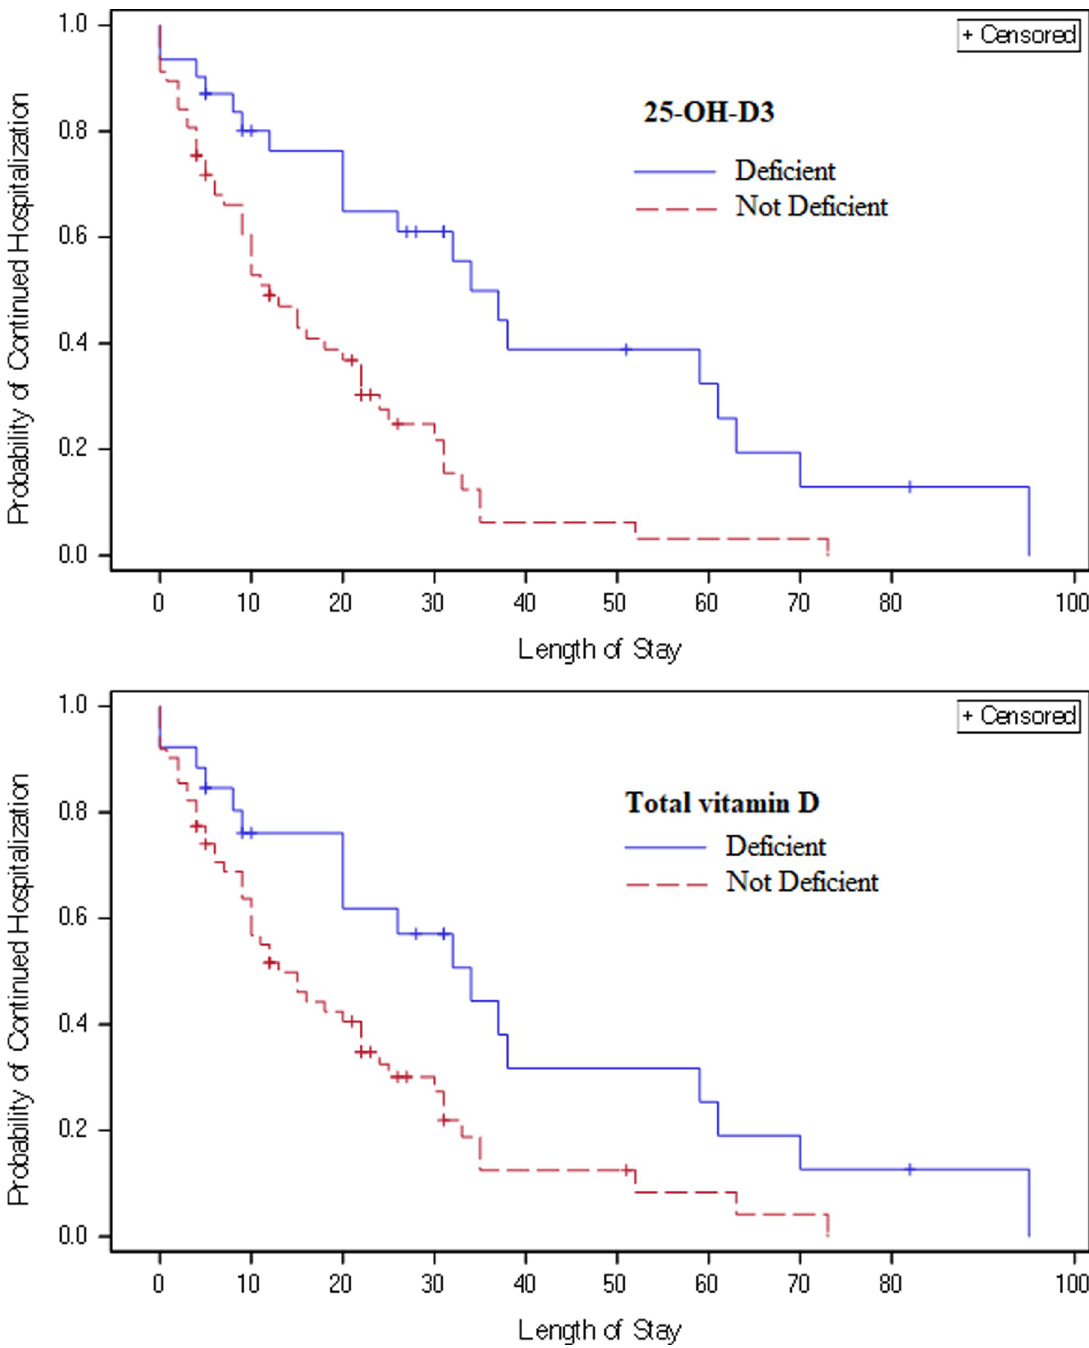
Fig 2. Kaplan-Meier curves for hospital discharge. Unadjusted Kaplan-Meier curves for hospital discharge by 25-OH-D3 and tD levels above and below cutoffs. For 25-OH-D3, there were 11 patients censored at the time of death with deficient levels and 10 with non- deficient levels. For tD, 8 and 13 patients were censored at time of death for deficient and non-deficient levels,